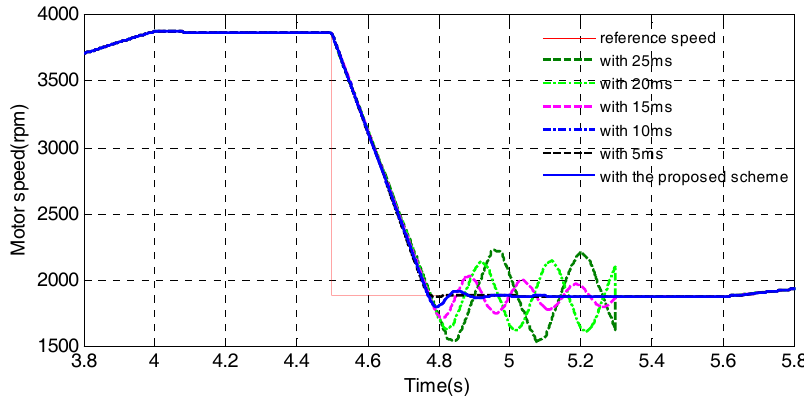
( b ) Figure 11. Hardware-In-the-Loop (HIL) test system. ( a ) A real CAN-based test system; and ( b ) Schematic diagram of the test system. ECU: electronic control unit. The test results are shown in Figures 12–14. These results show that, with different sampling periods, the speed synchronization control responses and the CAN utilization rates of the loop are similar to the ones in the previous simulations. The HIL test results illustrate that only the proposed scheme can guarantee satisfactory speed synchronization performance while obviously reducing the network utilization rate in a real CAN environment. In contrast, the conventional fixed sampling